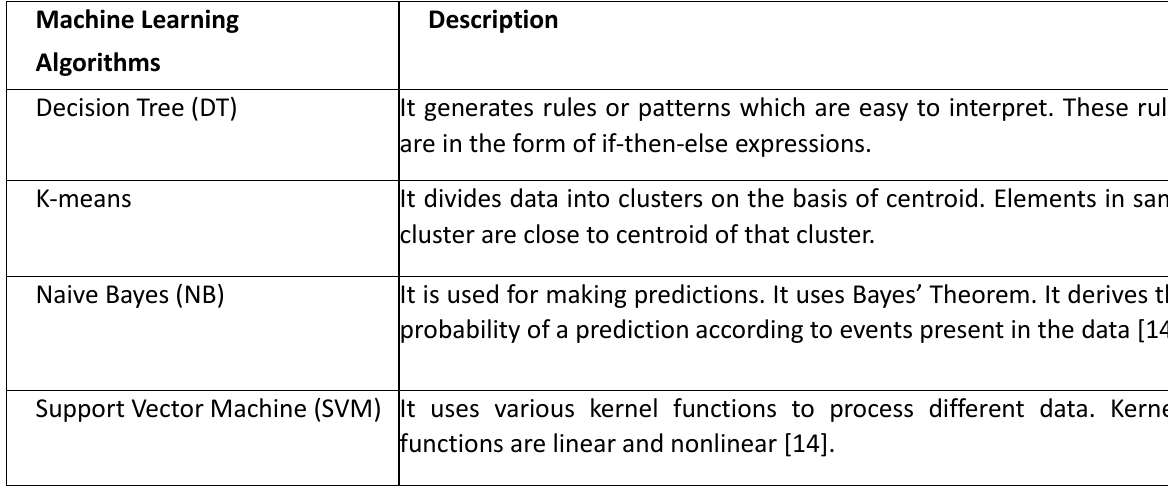
Table one: Different Machine Learning Algorithms employed for category and clustering